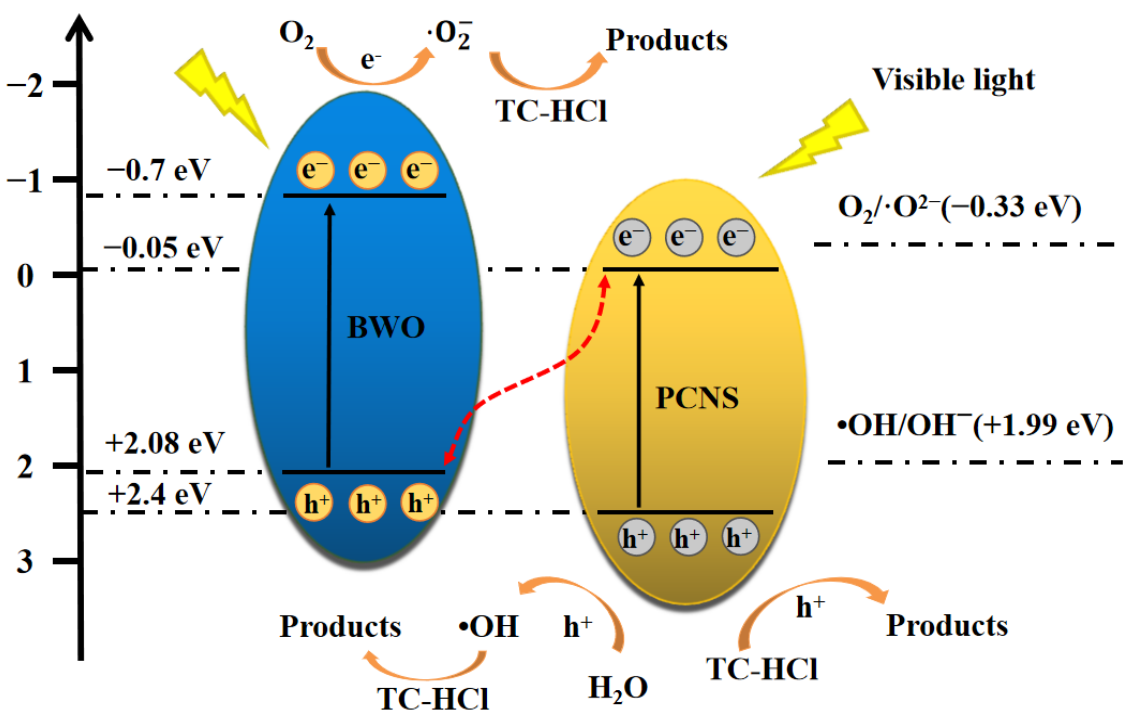
Figure 14. Mechanism of TC-HCl degradation catalyzed by 30% PCNS/BWO.